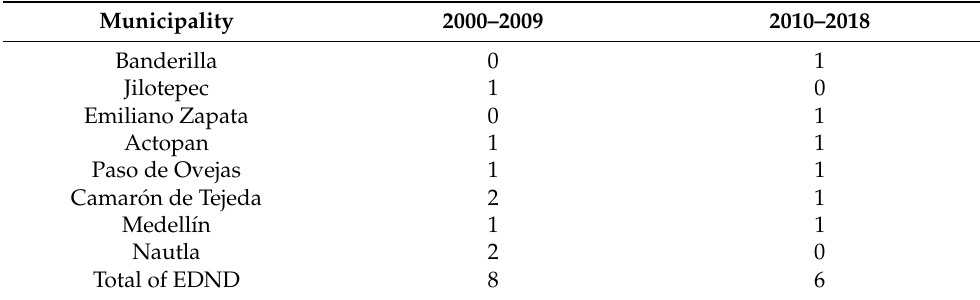
Table A2. Number of EDND declared between 2000–2009 and 2010–2018 in the study zone munici-